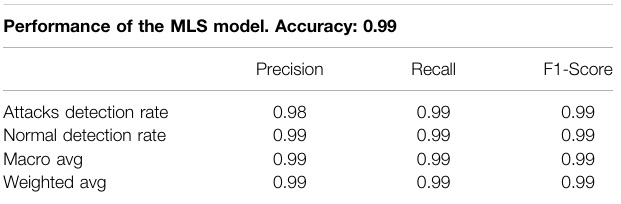
TABLE 2 | MLS model response for 10 samples of fl oaded to the MEC